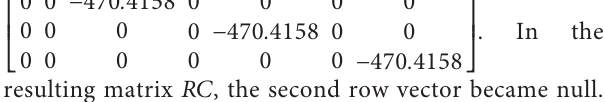
resulting matrix RC , the second row vector became null.